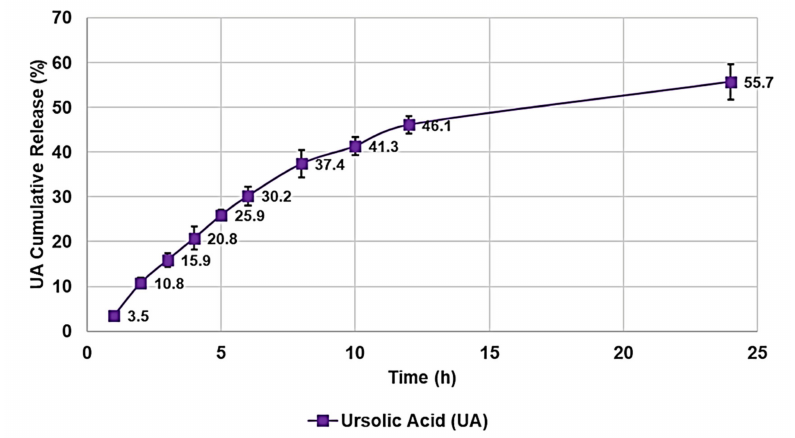
Figure 11. UA cumulative release (%) at pH 7.4 monitored for 24 h.